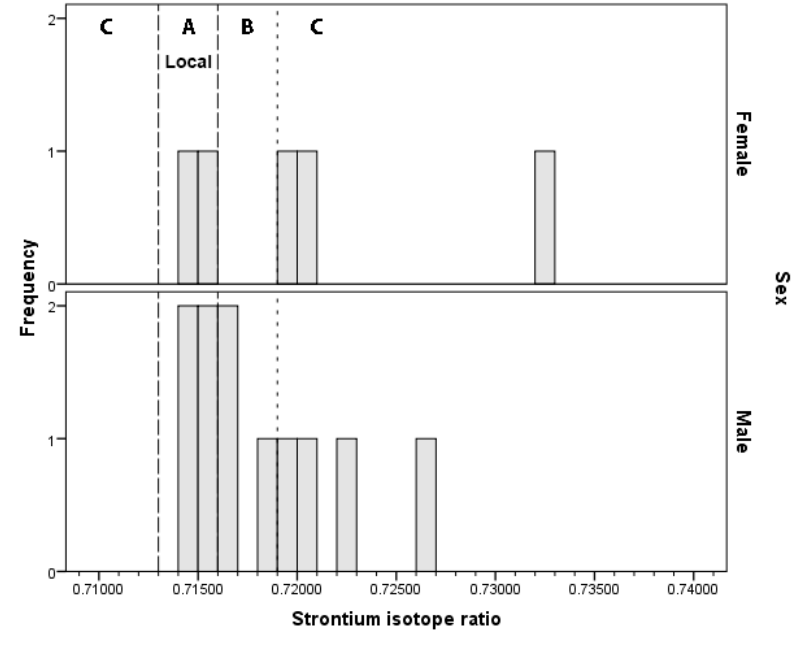
Figure 12. Histogram of strontium isotope ratios compared to sex, Falköping stad 5. A: Local 87 Sr/ 86 Sr ratios, B: non-local/ mixed 87 Sr/ 86 Sr ratios, C: non-local 87 Sr/ 86 Sr ratios, see text above. The local and non-local signals of Falbygden are based on earlier and ongoing research.